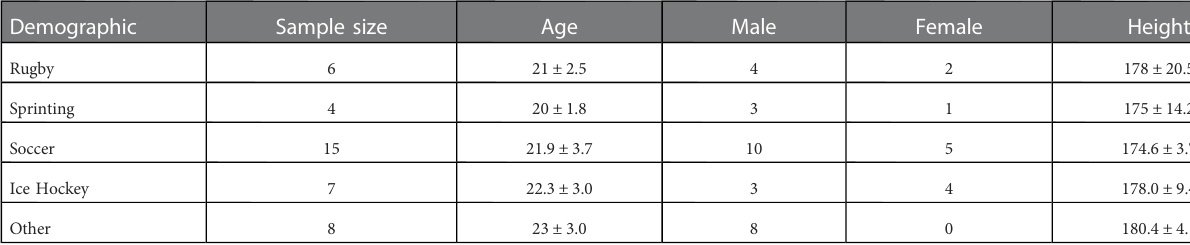
TABLE 1 Mean ± SEM participant